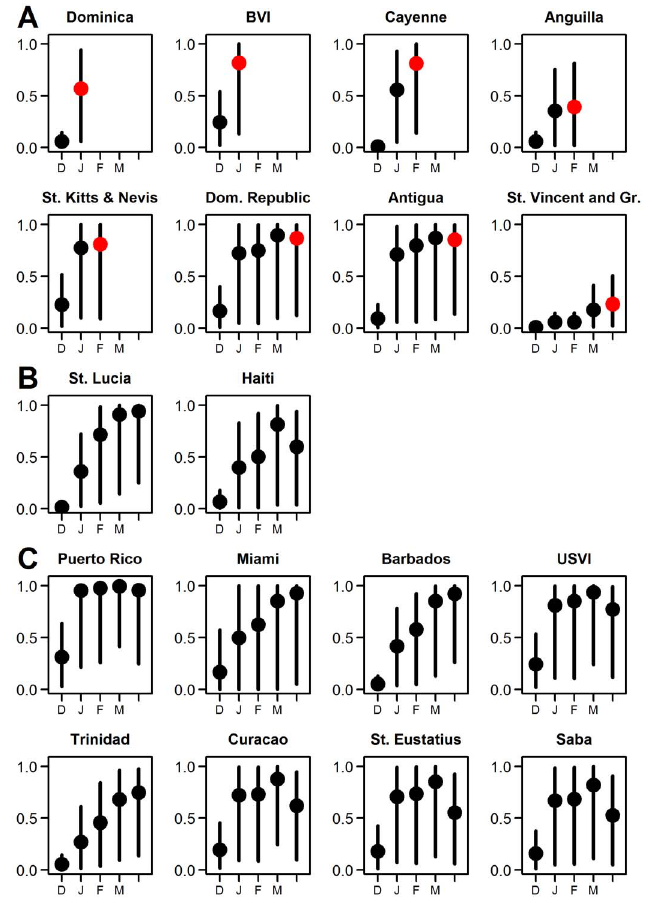
Figure 3. Monthly probabilities of local transmission of chikungunya virus for select locations, December 2013–April 2014. Mean estimates (points) and 95% percentiles (lines) of predictions for the probability of introduced local transmission by month (December (D), January (J), February (F), March (M), and April (A)). A. Locations with reported autochthonous cases prior to May 2, 2104. The red points represent the month when cases were first reported. B. St. Lucia and Haiti had reported cases in early May. C. The eight locations with a predicted probability of local transmission greater than 0.5 in April and no history of cases as of May 16. BVI: British Virgin Islands; USVI: U.S. Virgin Islands.